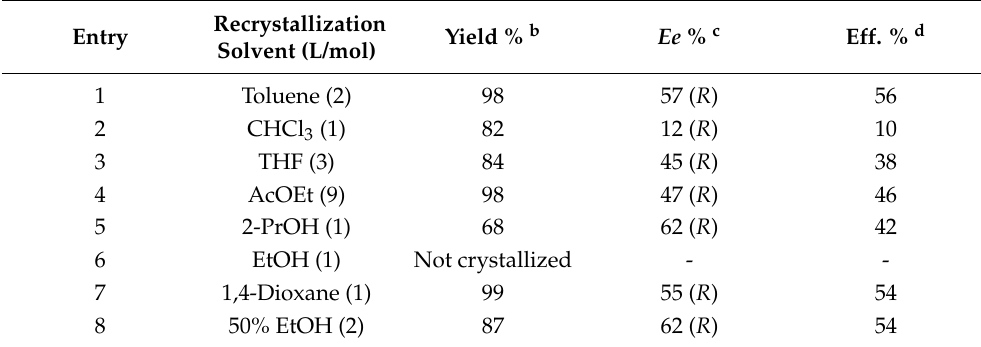
Table 6. Optical resolution of racemic 3-hydroxy-5-phenylpentanoic acid ( rac - 3 ) with cinchonidine a